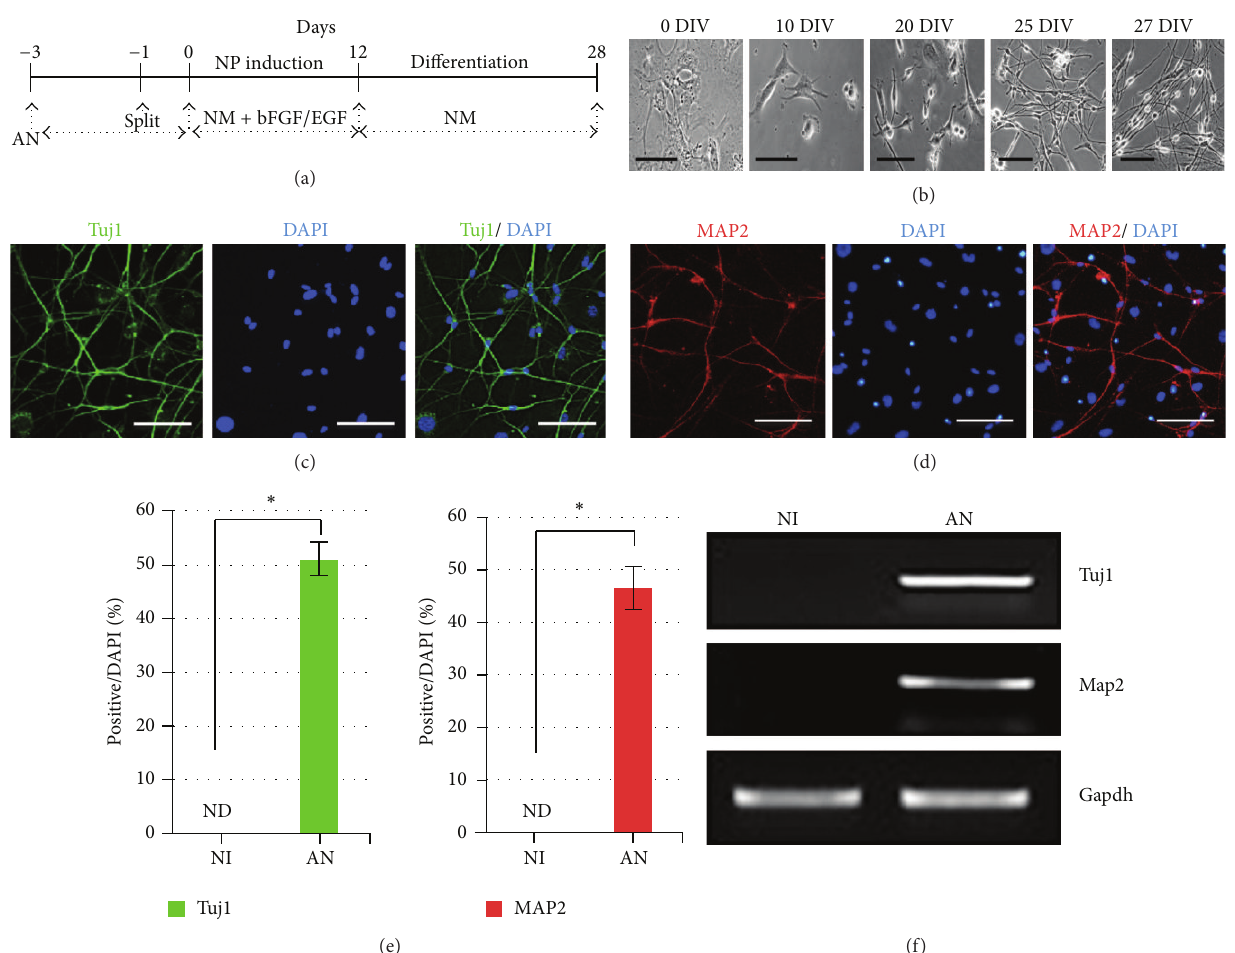
Figure3:DirectconversionofMEFcellsintoneurons.(a)AschematicdiagramofthegenerationofMEF-derivedneurons.(b)Representative phase-contrast images of neuron-like cells showing bipolar projections. Magnification × 200; scale bar is 100 𝜇 m. ((c), (d)) Representative immunofluorescence image of differentiated MEF cells stained with Tuj1 and MAP2 antibodies. Magnification × 200; scale bar is 50 𝜇 m. (e) Reprogramming efficiency of the MEF cells into neuronal cells. Tuj1-positive (green bar) and MAP2-positive (red bar) cells per DAPI-positive cells. Single asterisk is 𝑃 < 0.01 . (f) mRNA expression of neuronal cell marker genes Tuj1 and Map2 by